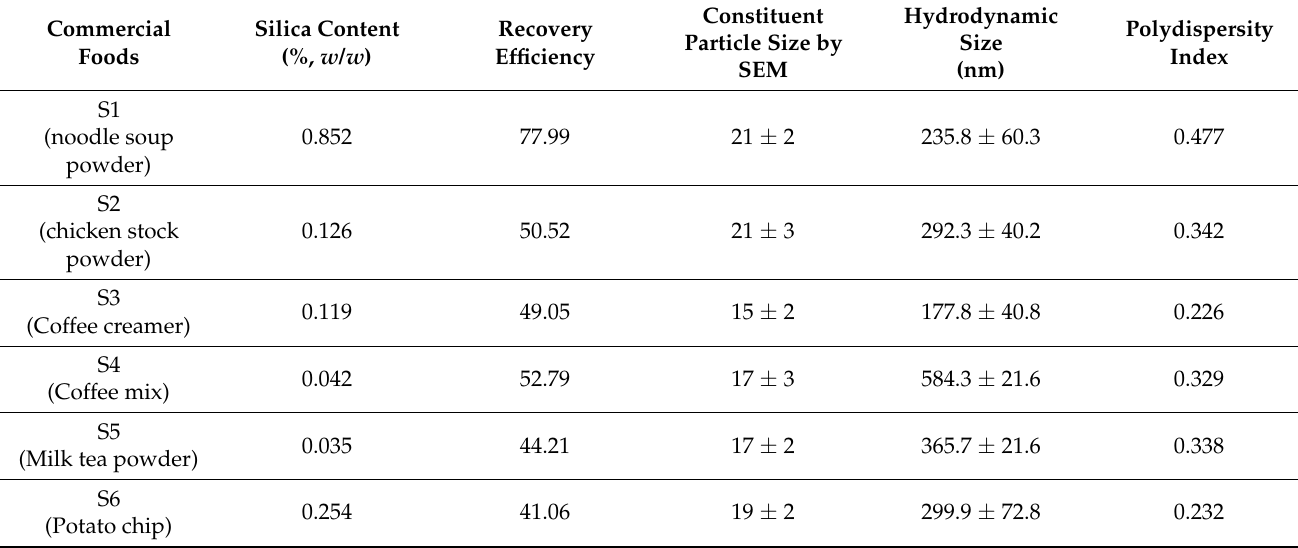
Table 1. The characteristics of SiO 2 particles extracted from six commercial processed